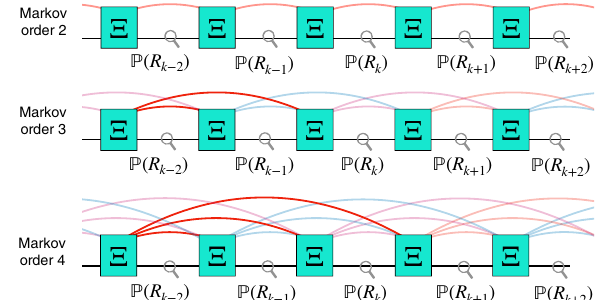
FIG. 3. Memory in non-Markovian processes. For processes with memory, besides the state of the system at present, we need additional information about the past to correctly predict future statistics. If only the probability of the next outcome is of inter- est, then a map (cid:5) ( m ) of the form of Eq. (24) is sufficient, if all future probabilities are to be computed via the concatenation of a single map, then (cid:6) , given in Eq. (26), is required. Together, the system and memory undergo Markovian